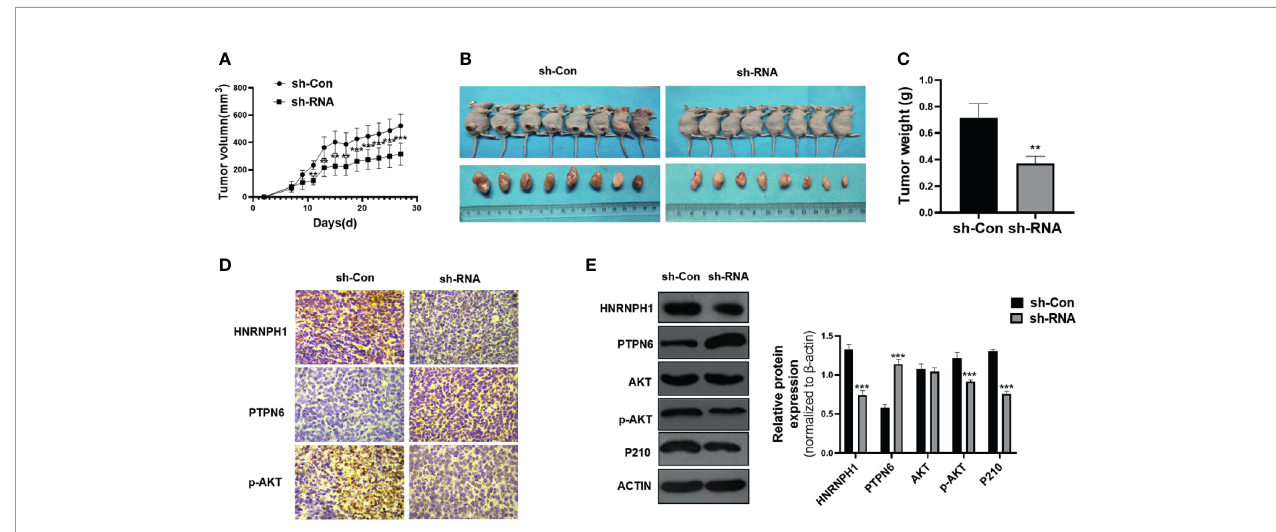
FIGURE 6 | HNRNPH1 downregulation inhibits CML cell growth in vivo . (A) K562 cells were engineered to stably knockdown HNRNPH1 and the cells were then subcutaneously injected into the nude mice to establish CML xenograft tumors. Tumor volumes were monitored by direct measurement. **P < 0.01, ***P < 0.001 vs. sh-Con. (B) Representative tumor sizes of xenograft mice in each group. (C) The xenograft tumor wet weight in each group of mice. **P < 0.01 vs. sh-Con. (D) Immunohistochemistry stain was used to measure the HNRNPH1, PTPN6, and P-AKT protein levels in xenograft tumors. (E) Western blot was used to detect the PTPN6, p-AKT, AKT, and P210BCR-ABL protein levels in xenograft tumors. Right panel, densitometric analysis. ***P < 0.001 vs.